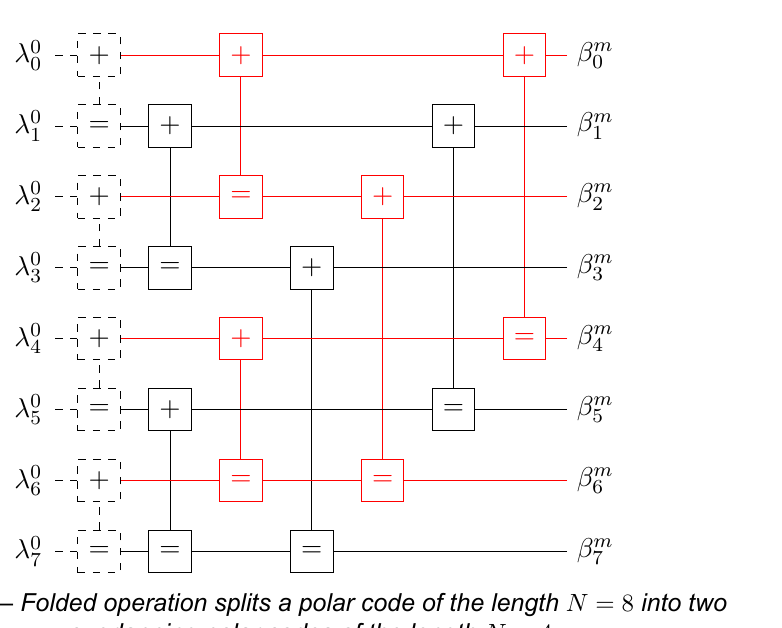
Figure 4 – Folded operation splits a polar code of the length N = 8 into two overlapping polar codes of the length N = 4